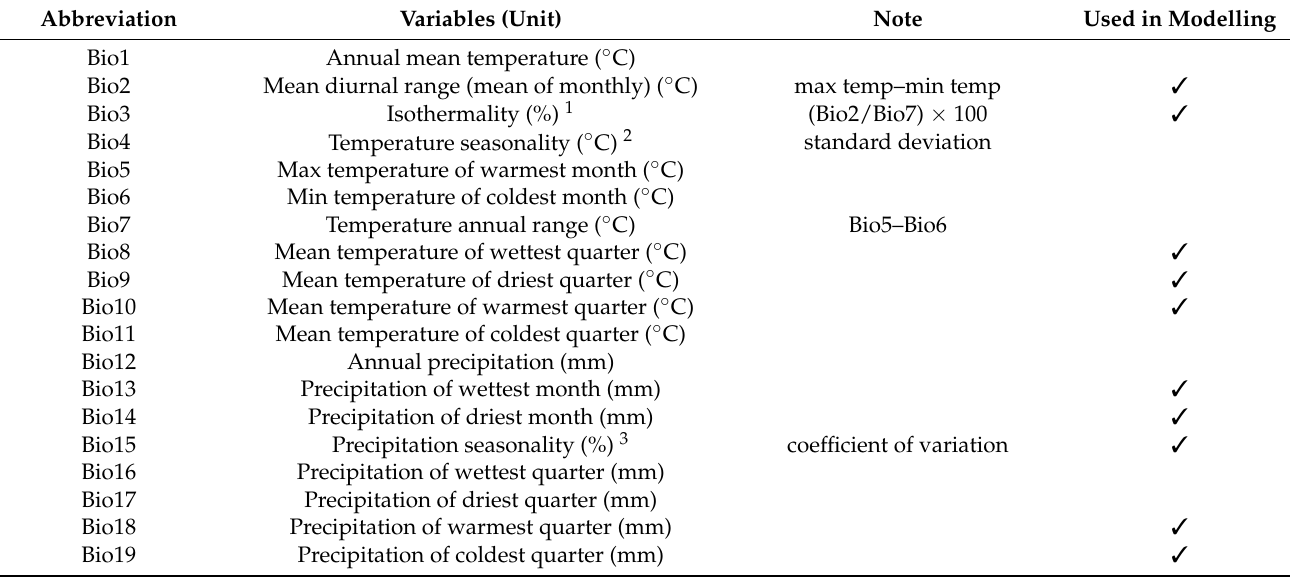
Table 3. Nineteen climatic variables and their abbreviations. After removing collinearity among the variables, 10 variables were used in the model (variables with (cid:51)